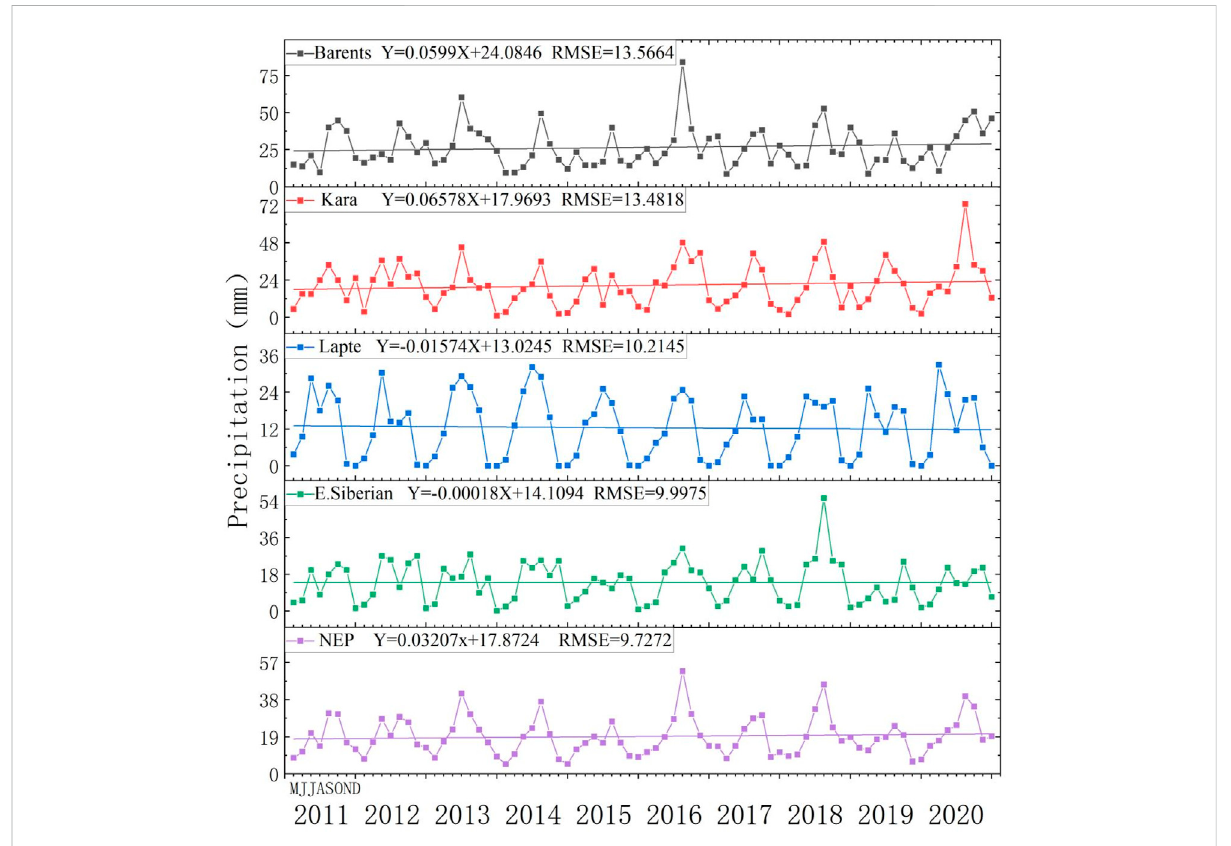
FIGURE 4 Results of linear regression of monthly precipitation from May to December for the period 2011 – 2020. It can be seen that, overall, the amount ofprecipitationintheNEPisincreasing.AmongthedivisionsoftheNEP,theprecipitationisincreasingintheBarentsSeaandKaraSea,whereasinthe Laptev Sea and East Siberian Sea it is